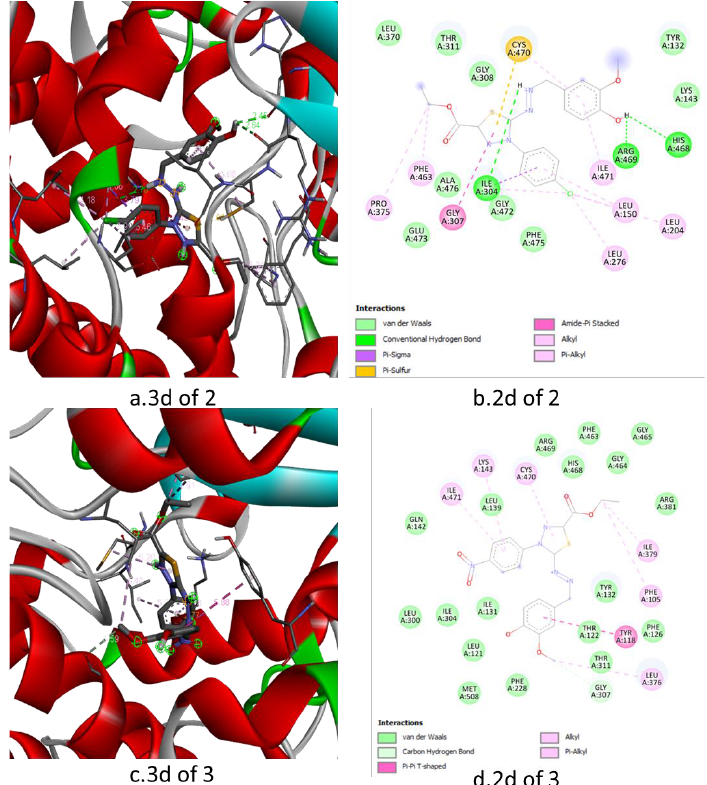
Figure 11. Interaction of the docked compounds 2 and 3 with fungal sterol 14 α -demethylase (CYP51).